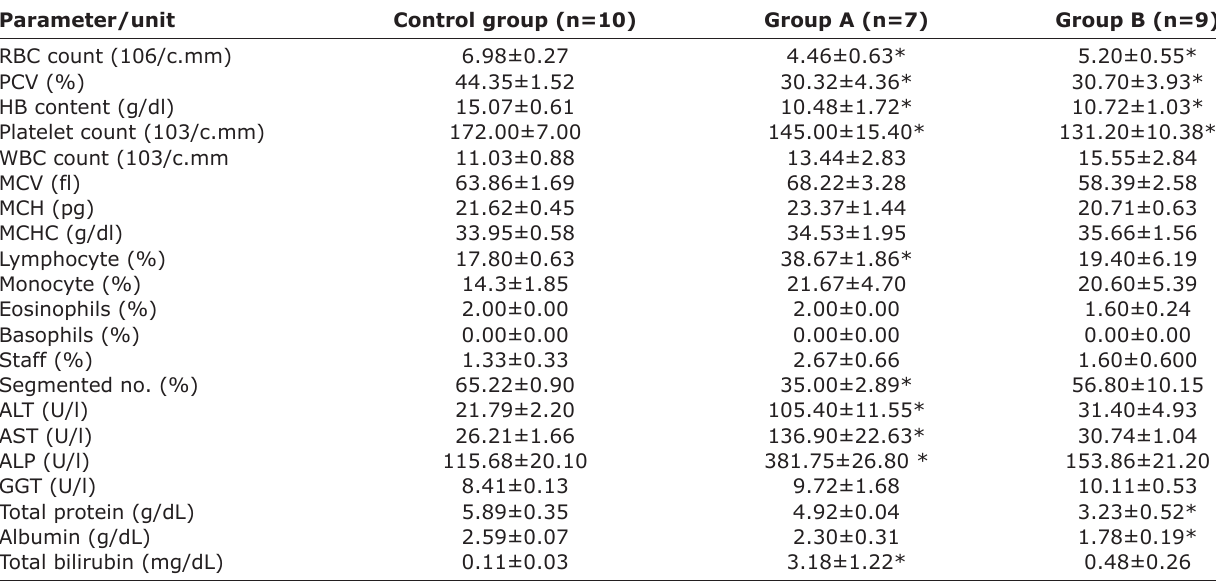
Table-3: Hematology and biochemistry analysis. Parameter/unit